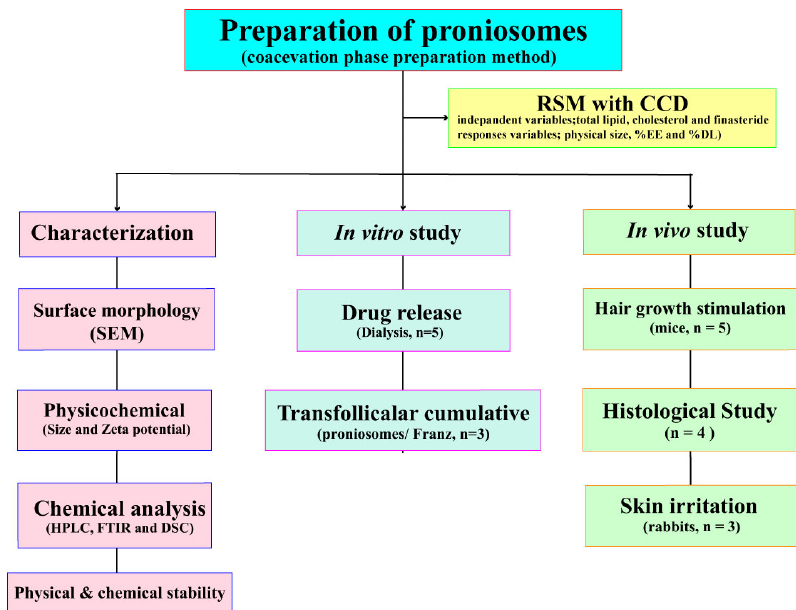
Figure 2. The flow diagram detailing the methodology of the study.